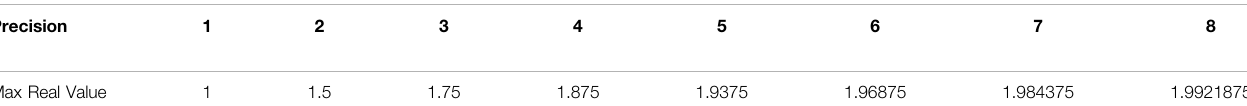
TABLE 1 | Maximum bound for reals for various precisions with fi xed point after position 1. Precision n